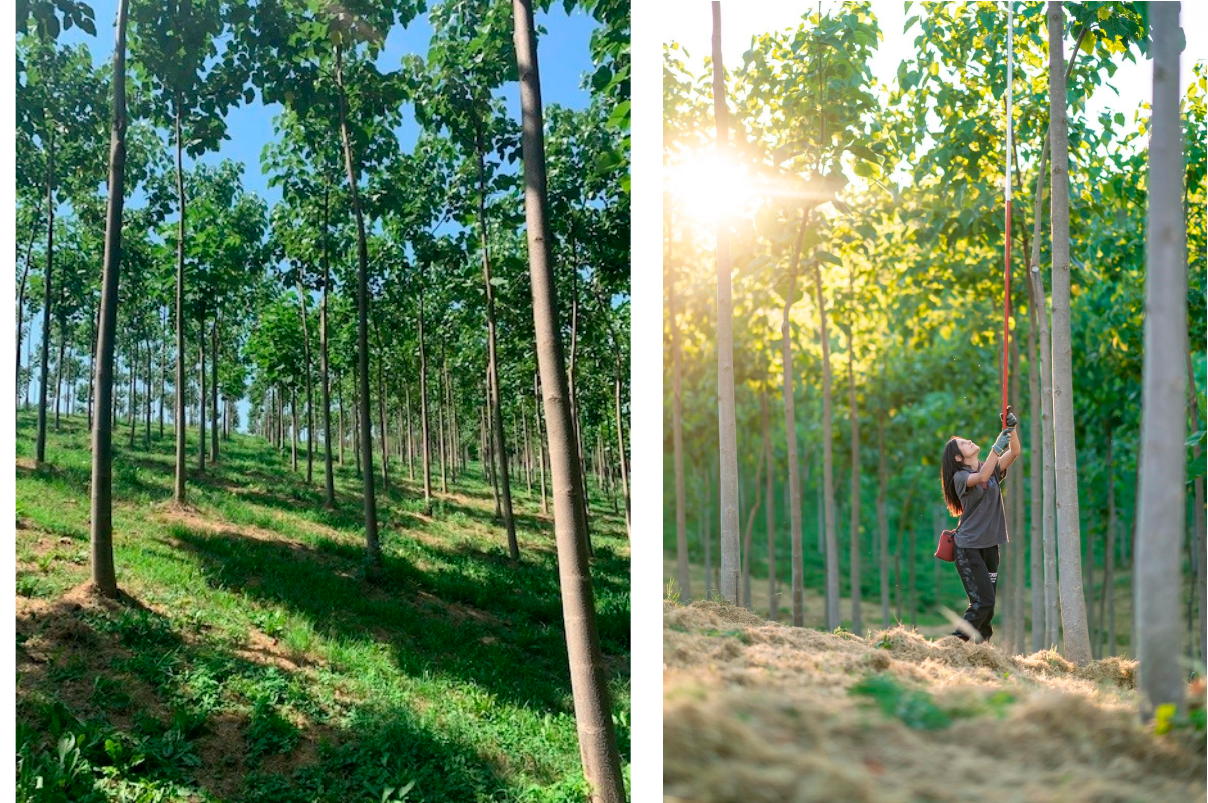
Figure 1. Paulownia plantation managed by Glendor GmbH with 7-year-old trees. The logs were labelled 1–4, with log 1 and 2 belonging to the first tree and log 3 and 4 to the second tree (Figure 2).